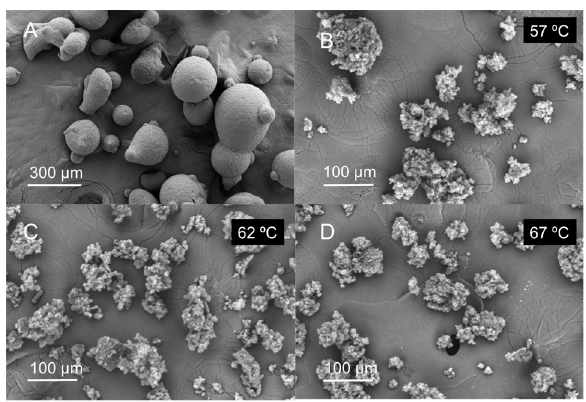
Figure 3. Effect of temperature in the PGSS ® processing of GMS particles: ( A ) unprocessed GMS particles and ( B ) GMS-1-57-200, ( C ) GMS-1-62-200 and ( D ) GMS-1-67-200 particles.